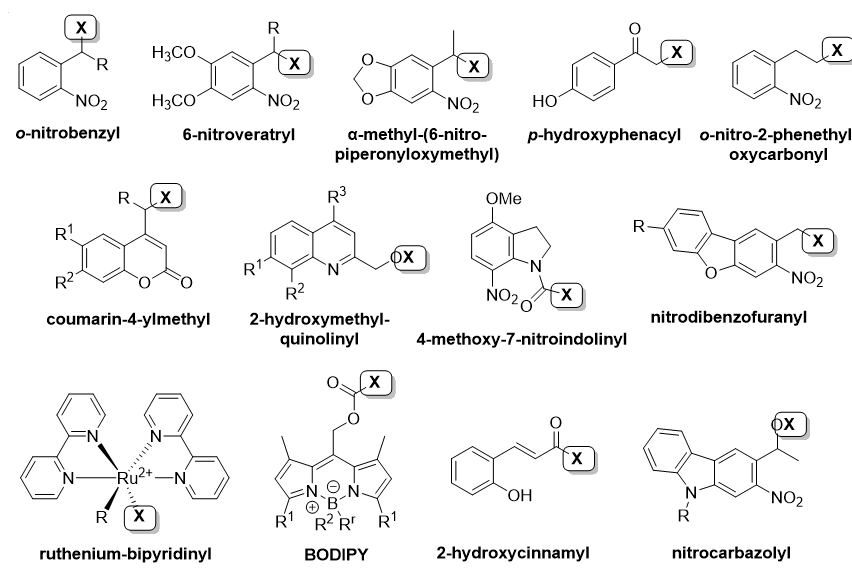
Figure 4. PPG scaffolds used for biological applications [4,36,37], ‘X’ indicating the substrate to be liberated via photoactivation.